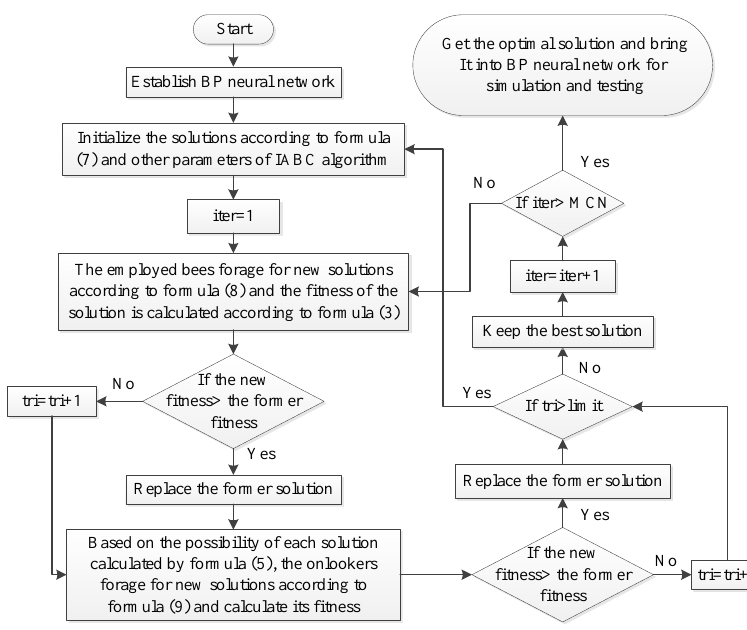
Figure 3. The flow chart of IABC-BP neural network.